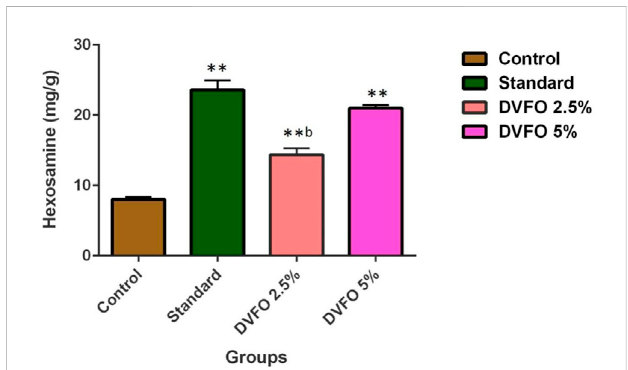
FIGURE 5 Effect of DVFO on hexosamine content. Values are expressed as Mean ± SD. Statistical analysis was done by Kruskal – Wallis followed by Mann-Whitney U test. Statistical signi fi cance: ** p < 0.01 vs. Control, b p < 0.01 vs. Povidone iodine-treated groups.